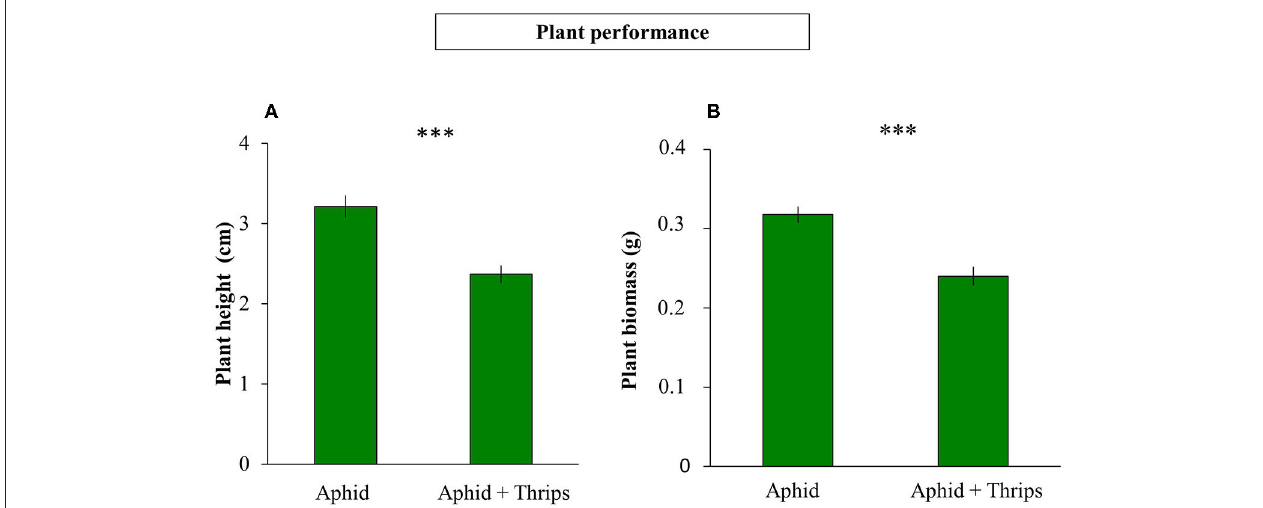
FIGURE 1 | Plant performance of 6-week-old sweet pepper after 1 week of herbivory: (A) plant height difference (before and after infestation with aphid vs. aphid + thrips); (B) total plant biomass. Bars represent means ± SE ( n = 20 replicates). Asterisks indicate significant differences between infestation treatments: *** P < 0.001 ( t -test).